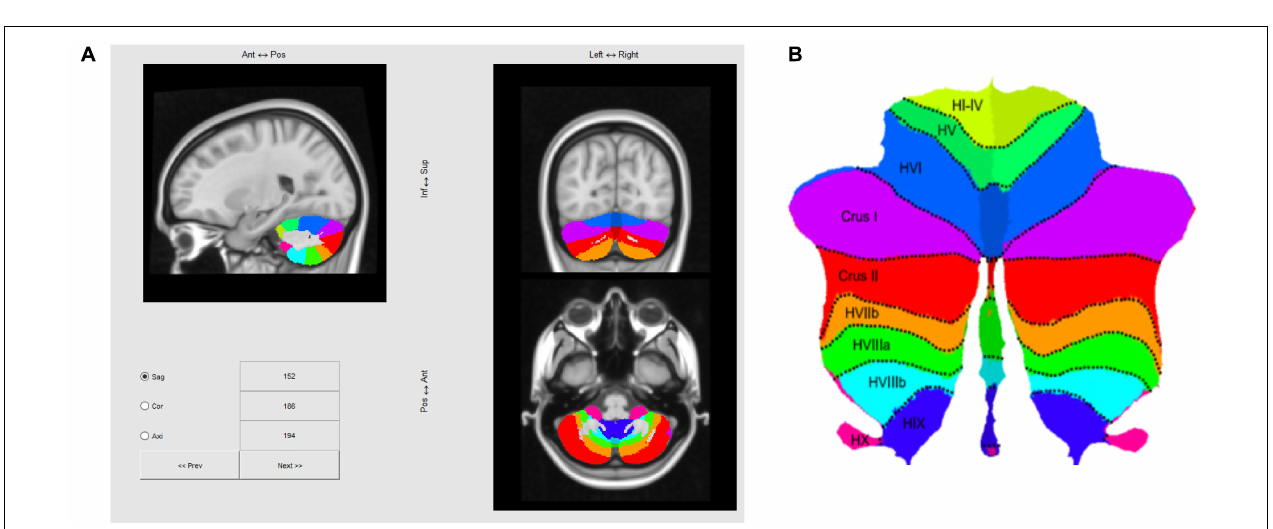
FIGURE 4 | (A) Three-slice volume view of the maximum probability atlas transformed by SUIT to the MNI152 T1 MRI scan used as the structural reference for registering multi-subject fMRI data in this study. (B) Probabilistic atlas of the cerebellar lobules projected to a flatmap of the cerebellum from the SUIT Matlab toolbox (Diedrichsen and Zotow, 2015;